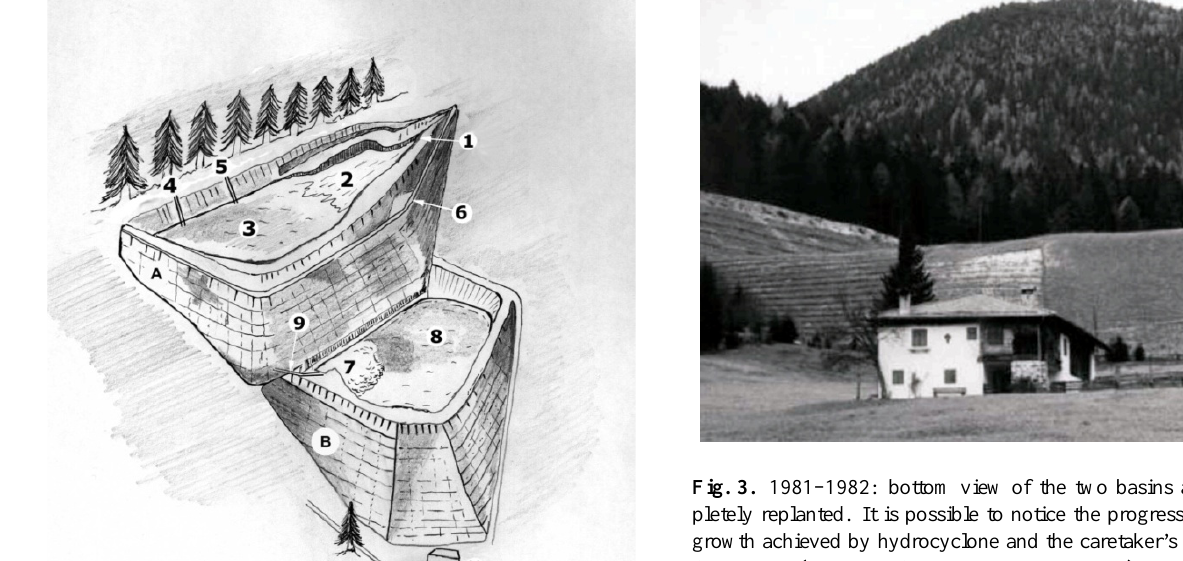
foreground (courtesy of Fondazione Stava,